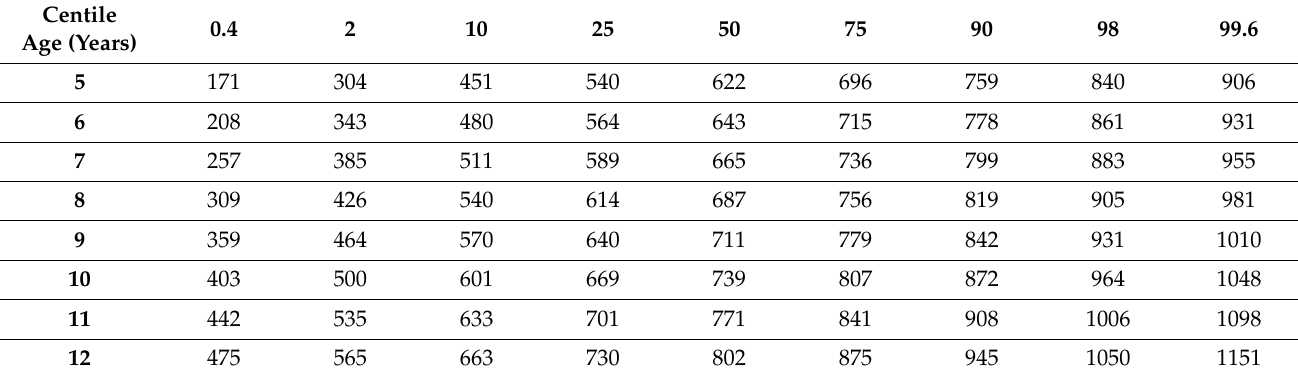
Figure 8. Centile chart for 4-min run in girls. Table 11. Values of particular centiles for 4-min run in girls.